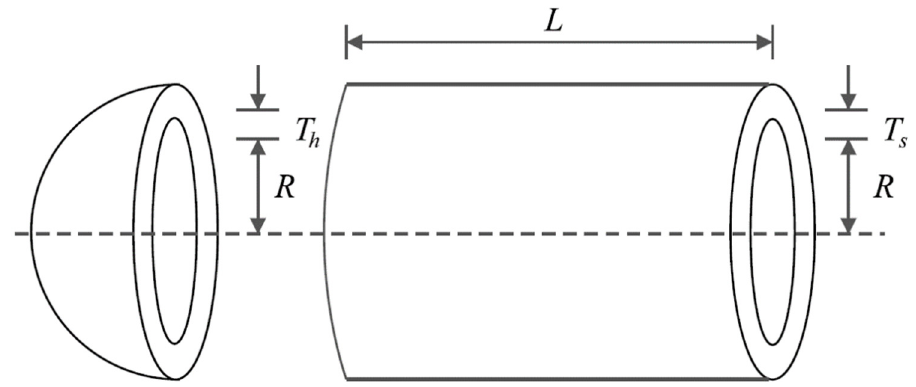
Figure 8. Schematic of the pressure vessel design.